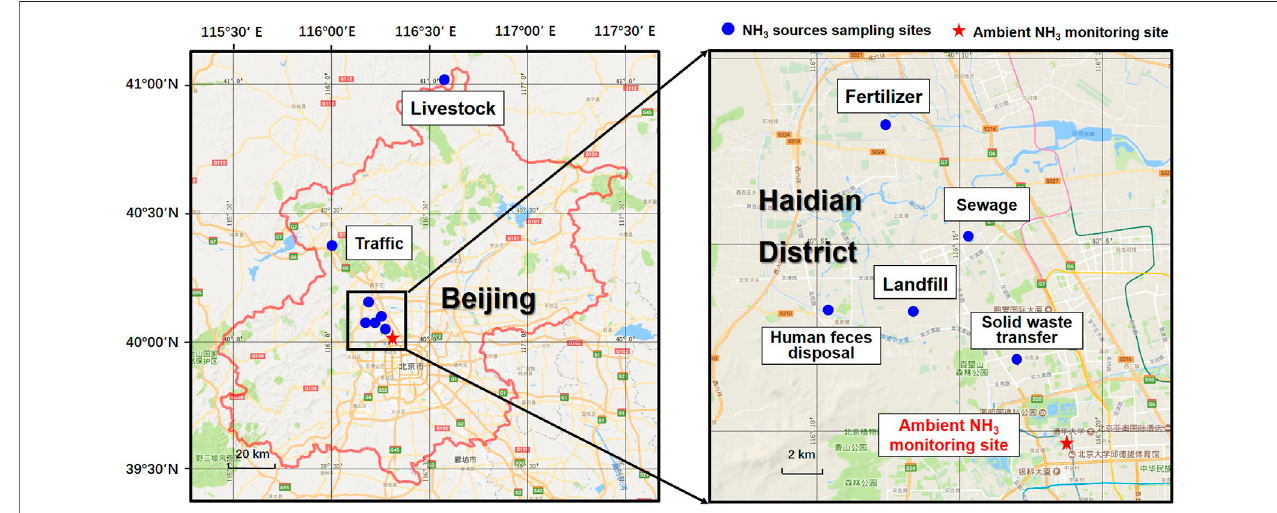
FIGURE 1 | The sampling locations of the NH 3 emission sources samples and ambient samples. The blue point indicates sites for collecting NH 3 source samples and the red pentagram shows the ambient air monitoring site.